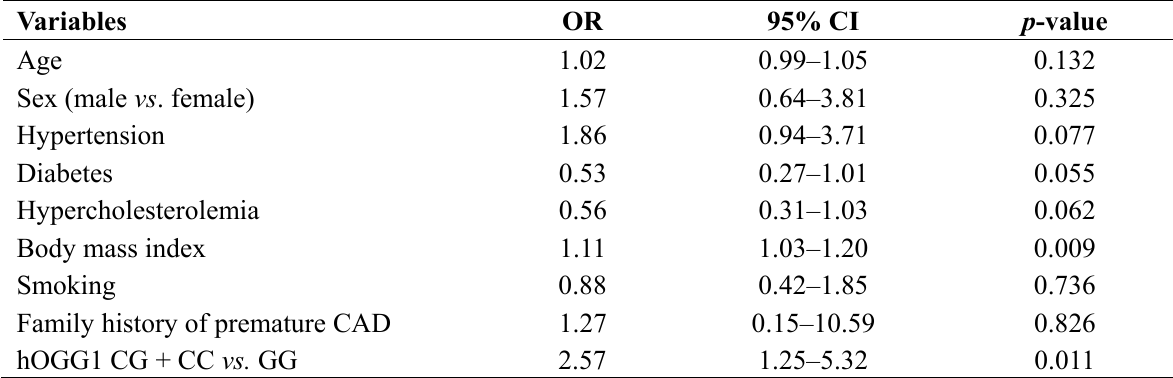
Table 5. Results obtained from the binary logistic